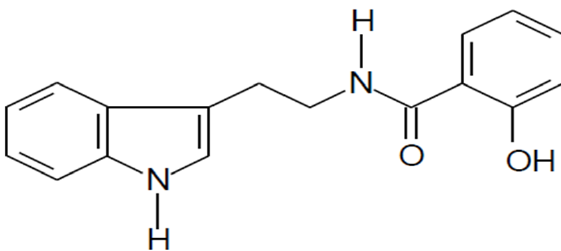
Figure 1 - Chemical structure of the N-salicyloyltryptamine